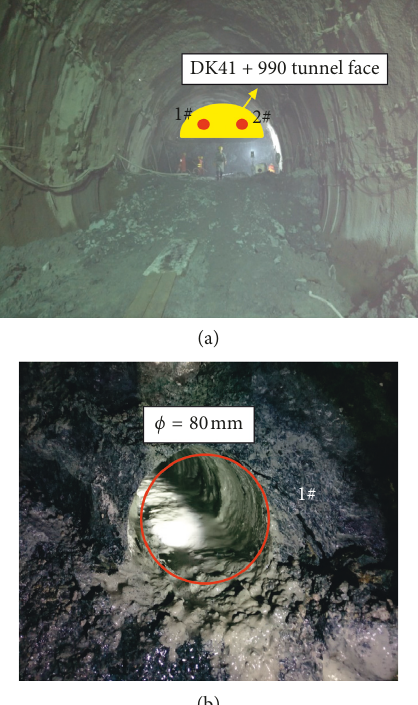
Figure 10: Arrangement of measuring points of the borehole shear